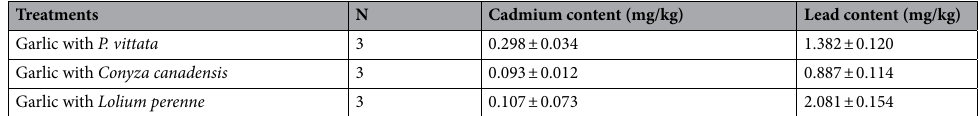
Treatments N Cadmium content